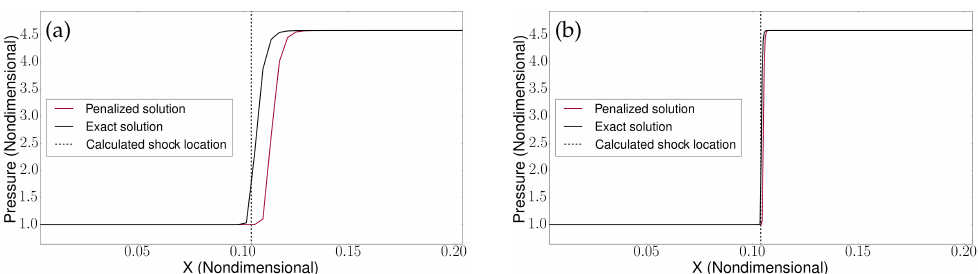
Figure 3. Pressure profiles along the shock tube for ( a ) coarse ( N = 2 9 ) and ( b ) fine ( N = 2 11 ) grid resolutions. The penalized solution for the reflected shock is compared with that obtained using exact algebraic boundary conditions. The theoretical shock location is also indicated.